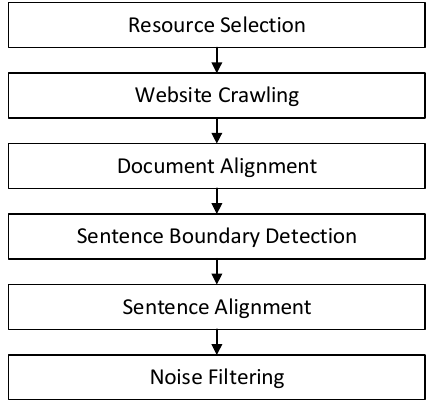
Figure 1. The acquisition process of UPC.